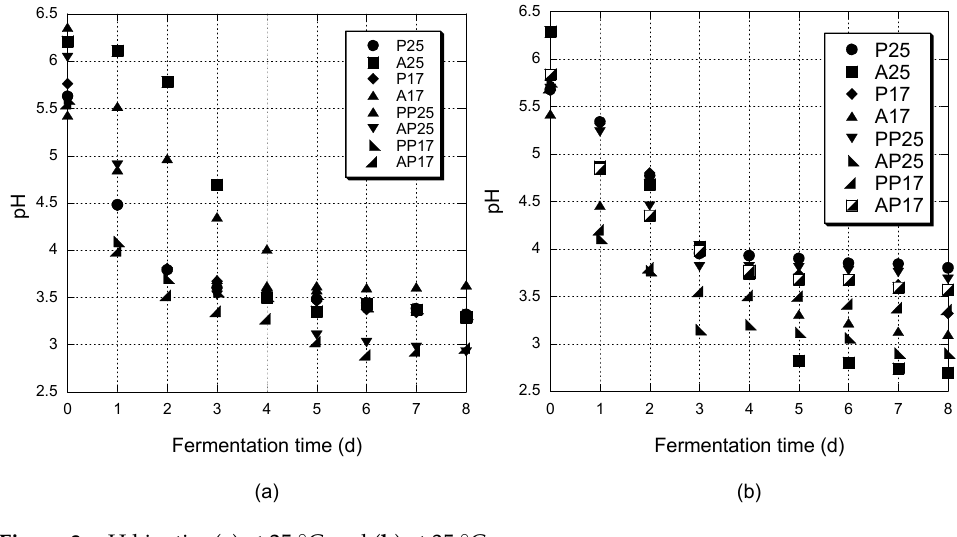
Figure 3. pH kinetics ( a ) at 25 °C and ( b ) at 35 °C.